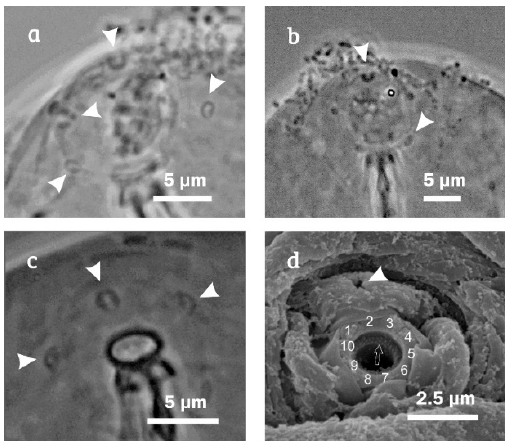
Figure 6. Minibiotus citlalium sp. nov. detail of the buccal opening with five pores around mouth: ( a ) paratype 15 (PCM); ( b ) paratype 13 (PCM); ( c ) holotype (PCM), white arrowhead indicates the buccal pores; and ( d ) detail of the buccal opening (ventral view, SEM) showing a buccal pore, the peribuccal papulae are show numbered 1 to 10, empty arrow indicates the teeth.